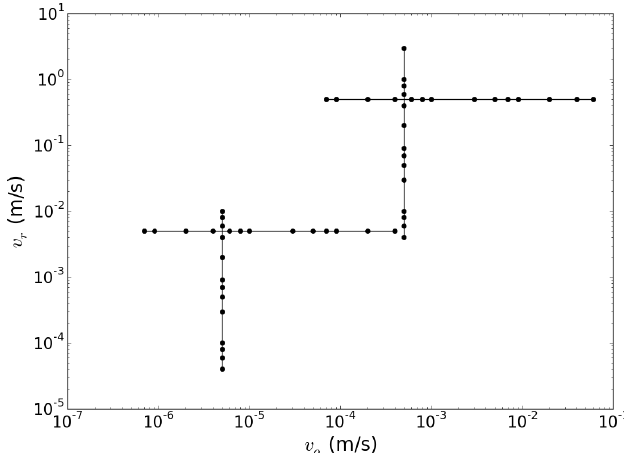
Figure 2. Two-dimensional parameter space of the simulations. Dots indicate the values of v and v used in the various simulations. r o Table 1. Physical parameters used in the simulations of the Lang–Kobayashi (LK)